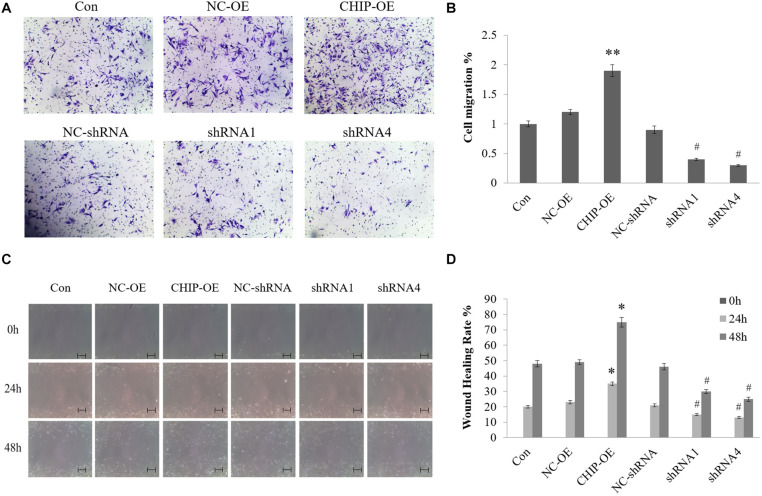
C terminus of Hsc70-interacting protein (CHIP) overexpression enhanced cell migration and cell invasion after in vitro simulated traumatic brain injury. (A) Invasion capacity of the cells was evaluated by the transwell assay. Cells were stained with crystal violet and counted in five randomly selected microscopic fields. (B) Quantitative statistics of invasion capacity. ∗∗p < 0.01 vs. the NC-OE, #p < 0.05 vs. the NC-shRNA. (C) Migration capacity of the cells was evaluated by the wound healing test. 3 × 105 cells were seeded in the Bioflex 6-well plates for 12 h, followed by in vitro stretch-induced injury treatment. Wound healing was observed after 0, 24, and 48 h within the scrape line, and representative scrape lines were imaged. (D) Quantitative statistics of migration capacity. ∗p < 0.05 vs. the NC-OE, #p < 0.05 vs. the NC-shRNA. Scale bars: 50 μm.